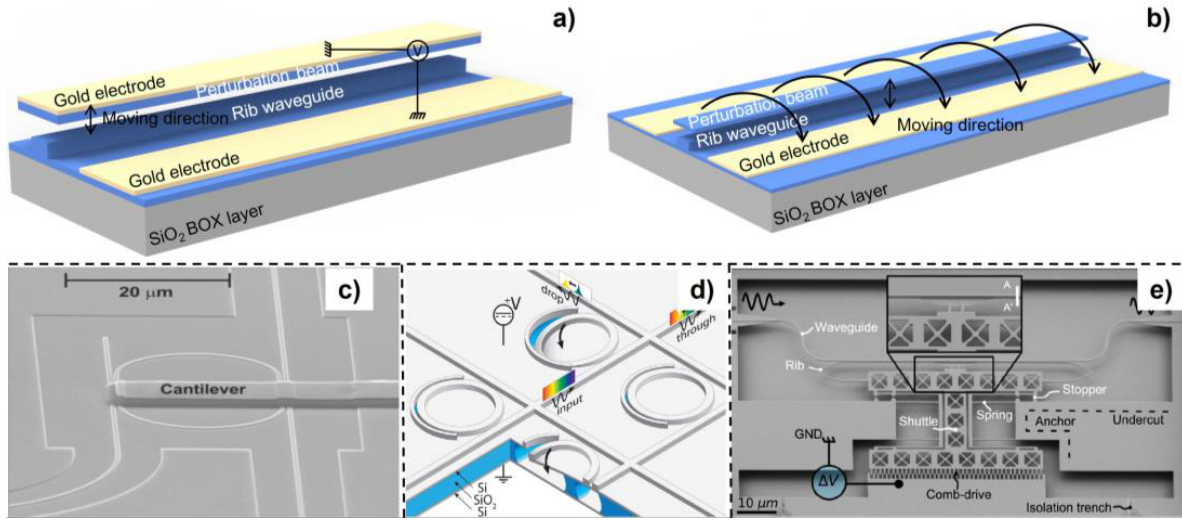
Figure 3. MEMS phase shifter through evanescent field perturbation utilizing ( a ) a silicon nitride beam coated with Au above the bus waveguide, ( b ) a pure silicon nitride beam actuated by gradient electric field force above the bus waveguide, ( c ) a silicon cantilever above the ring resonator (reprinted with permission from [54] © The Optical Society), ( d ) tunable ring resonator on the SOI (reprinted with permission from [55] © The Optical Society), ( e ) in-plane motion silicon beam perturbation (reprinted with permission from [45] © The Optical Society).